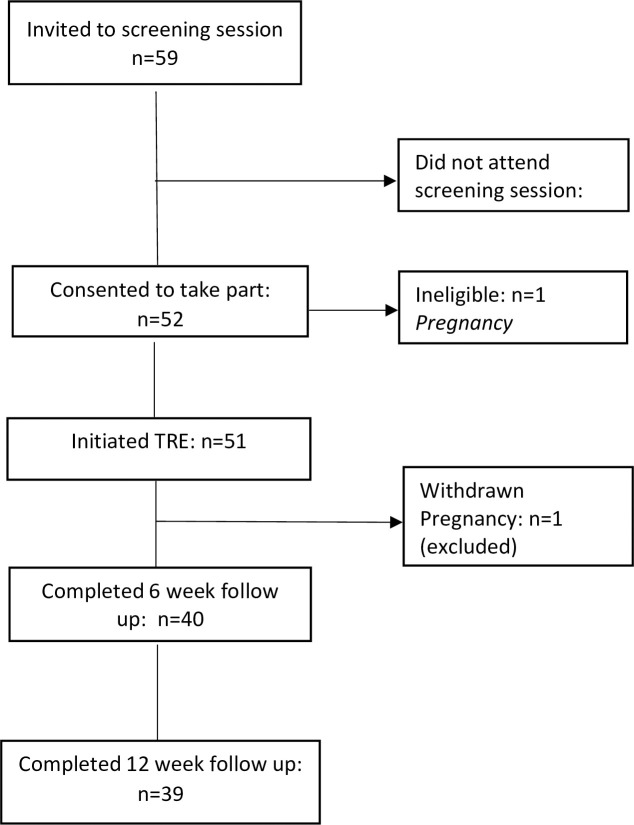
Participant flow.